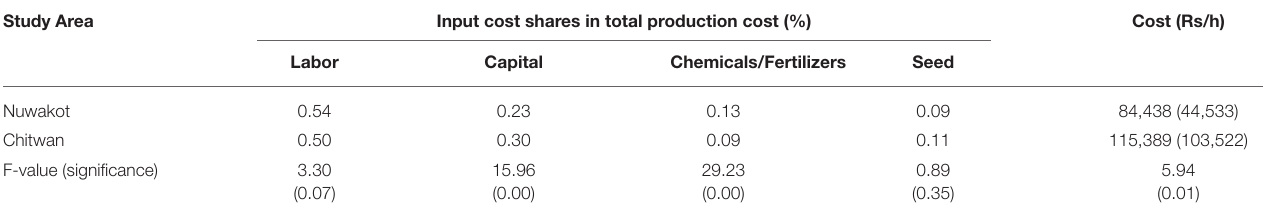
TABLE 9 | Cost of production and inputs cost shares (%) by study areas,